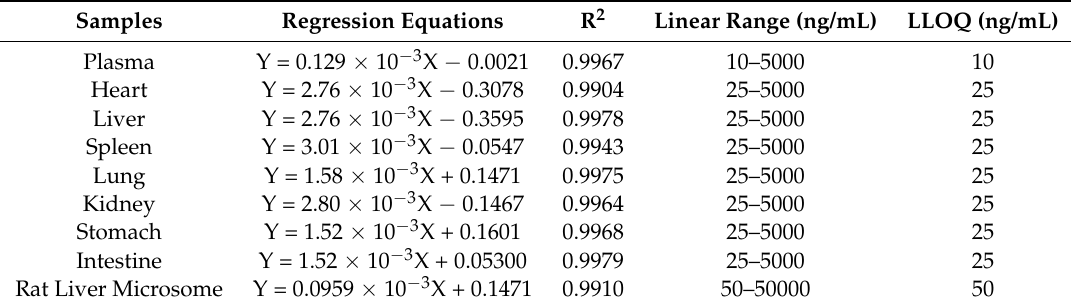
Table 1. The regression equations, linear ranges, and LLOQs for the determination of the analytes in rat biological samples.